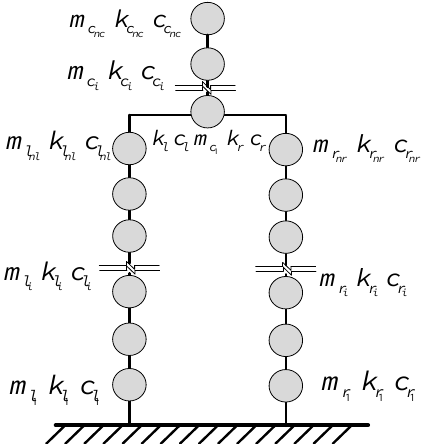
Figure 2. The simplified model of the connected structure. The connected structure proposed in this study has the same model as the original connected structure. The damping layer is a special floor that is commonly designed to concentrate and dissipate seismic energy to ensure the safety of the main structure. For convenience, the study examines the connected structure with a damping layer placed in the right building. The damping layer consists of one or more combinations of rubber isolation bearings, sliding plate bearings, and other dampers. Studies indicates that when the damper and isolation device (e.g., laminated rubber bearing or friction pendulum bearing) are applied together, the damper can not only dissipate the earthquake energy but also reduce the large relative displacement between the two ends of the isolation device [1,27,37,44,45]. In addition, the combination of negative stiffness element with lead rubber bearing (LRB) can also effectively suppress the deformation of LRB [46]. In this study, the energy dissipation story consists of a linear viscous damper and a laminated rubber bearing. A spring is used to simulate the laminated rubber bearing, and its equivalent stiffness is expressed as k h . The damper is simulated using a linear model, where the damping force is determined only by the multiplication of the difference in velocity between the two ends of the dampers and the damping coefficient c h . Thus, the simplified model is shown in Figure 3.